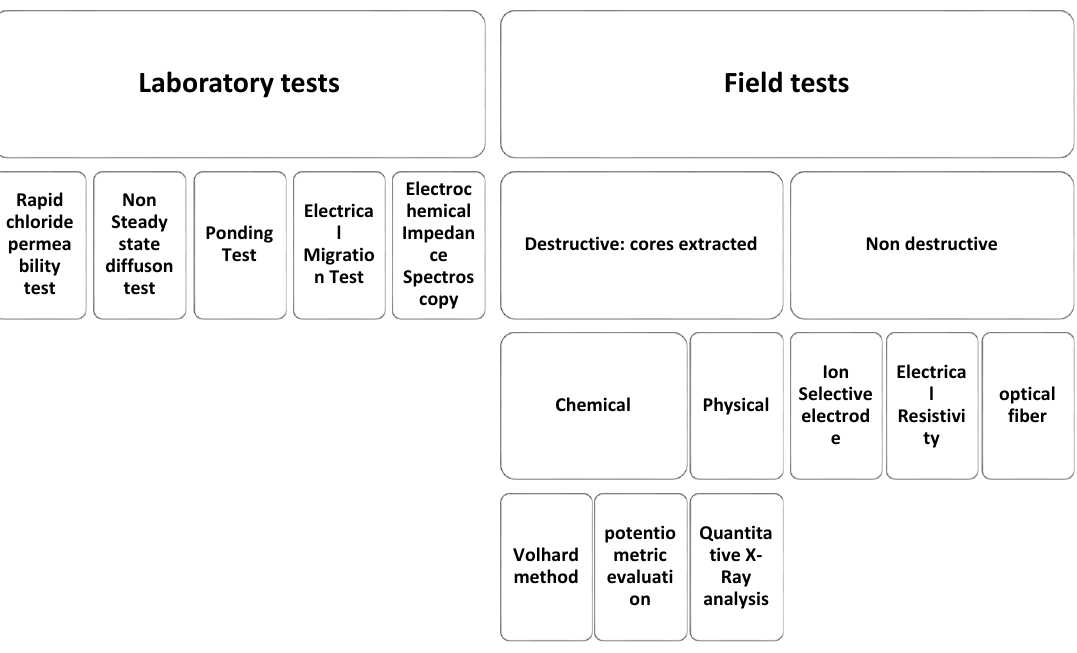
Figure 6. Chloride ionmeasurement techniques [4,53,60–66].